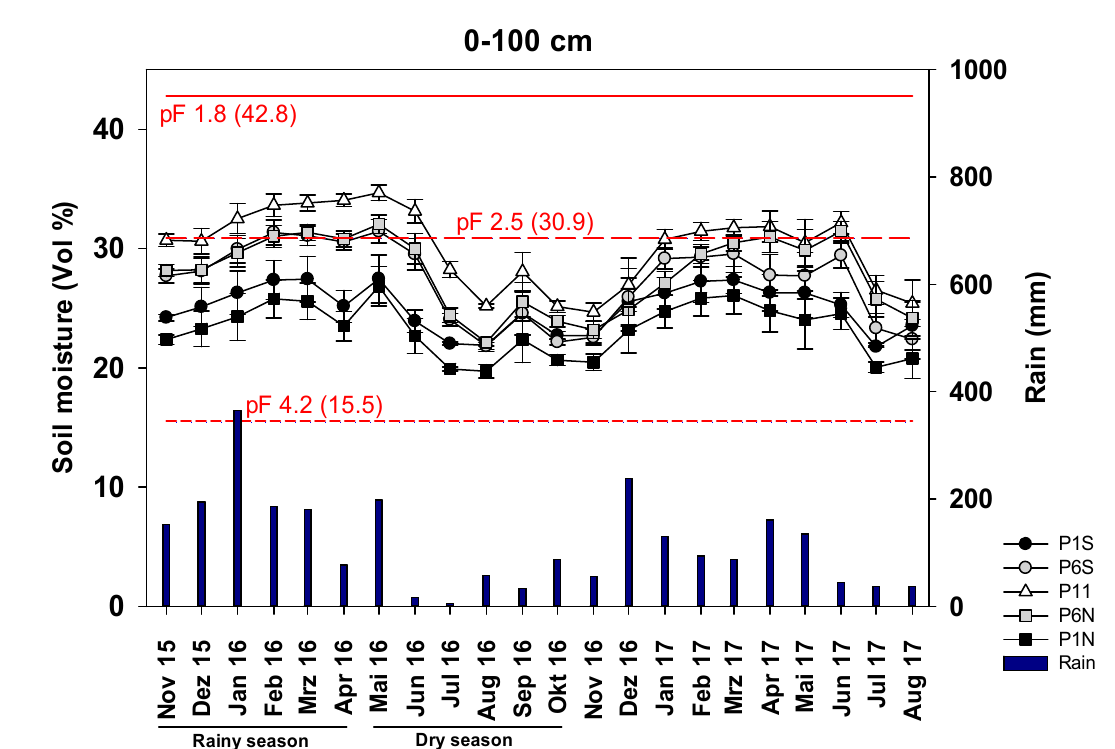
Figure 4. Monthly mean soil moisture (SM, in Vol%) for each sample point between the tree rows over 0–1 m soil depth from November 2015 until August 2017. P1S: 1 m and P6S: 6 m from southern row. P1N: 1 m and P6N: 6 m from northern row. P11: 11 m from southern and northern row respectively. Bars represent standard errors. Cumulative monthly rain (mm) from November 2015 until August 2017. Cumulative rain for year 1 (15 November–16 October) 1553 mm and for year 2 (16 November–17 August) 1020 mm. Dotted horizontal lines mark usable field capacity from pF 1.8 (field capacity) to pF 4.2 (permanent wilting point). Table 1. Analysis of variance for soil moisture 0–100 cm depth. ***: significant at p -value ≤ 0.001, respectively. Abbreviations: Df: degree of freedom; SS: sum of square; MS: mean